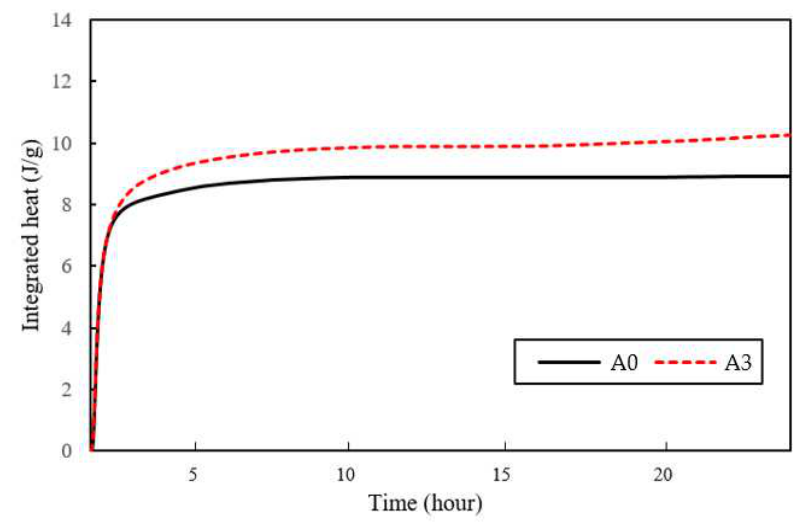
Figure 4. Integral heat outputs applied to the A0 and A3 specimens.